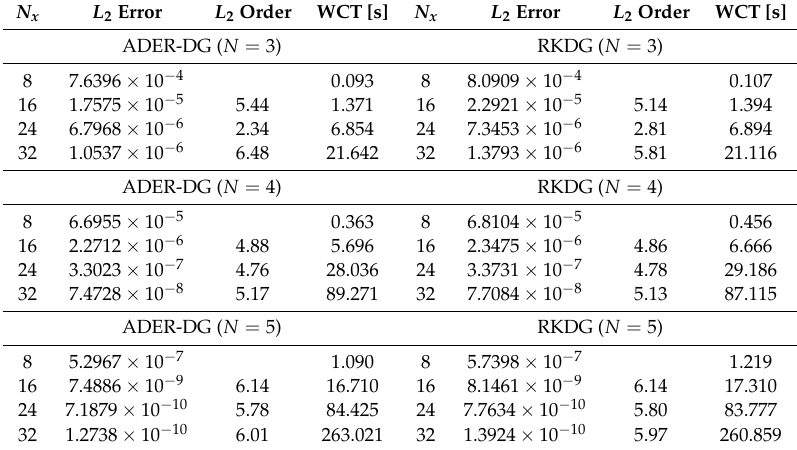
Table 2. Accuracy and cost comparison between ADER-DG and RKDG schemes of different orders for the GRMHD equations in three space dimensions. The errors refer to the variable B y . The table also contains total wall clock times (WCT) measured in seconds using 512 MPI ranks of the SuperMUC phase 1 system at the LRZ in Garching, Germany. N x L 2 Error L 2